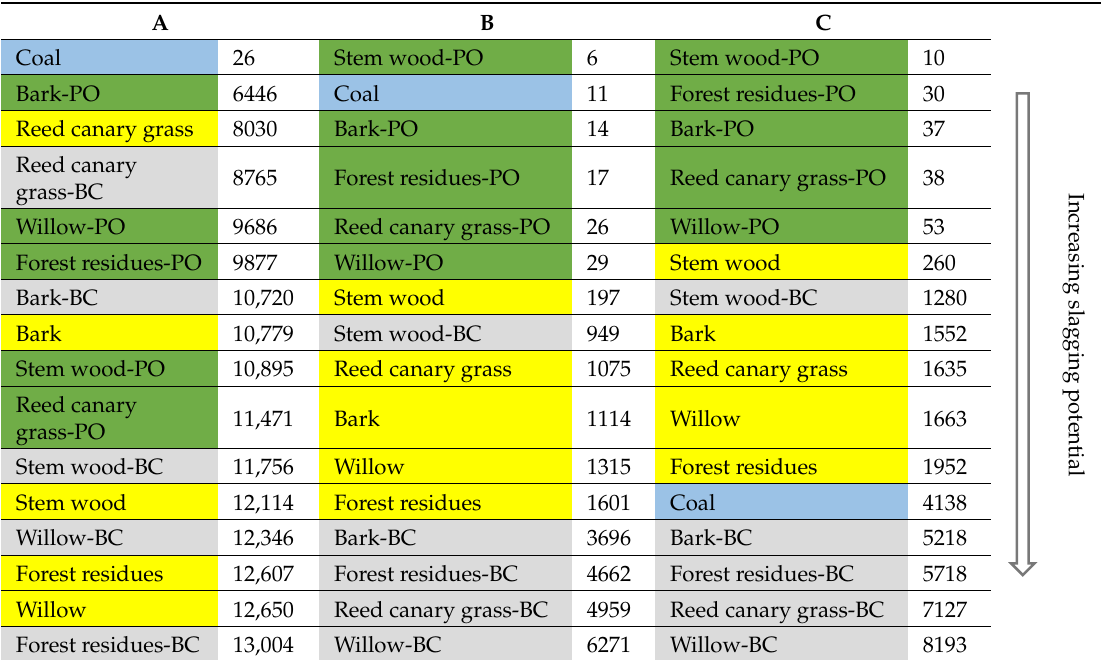
Table 1. The calculated slagging potential for the investigated fuels; Column A representing the calculated slagging potential for the transfer-chute (ADTs from Equation (2)); Column B representing that calculated for the transfer-chute (ADTs from Equation (5)); Column C representing that calculated for the rotary kiln (ADTs from Equation (5)). Each color represents a certain category of the investigated fuels where coal is indicated by blue, raw biomass, PO, and biochars are indicated by yellow, green, and gray, respectively. PO and BC stand for pyrolysis oil and biochar, respectively.